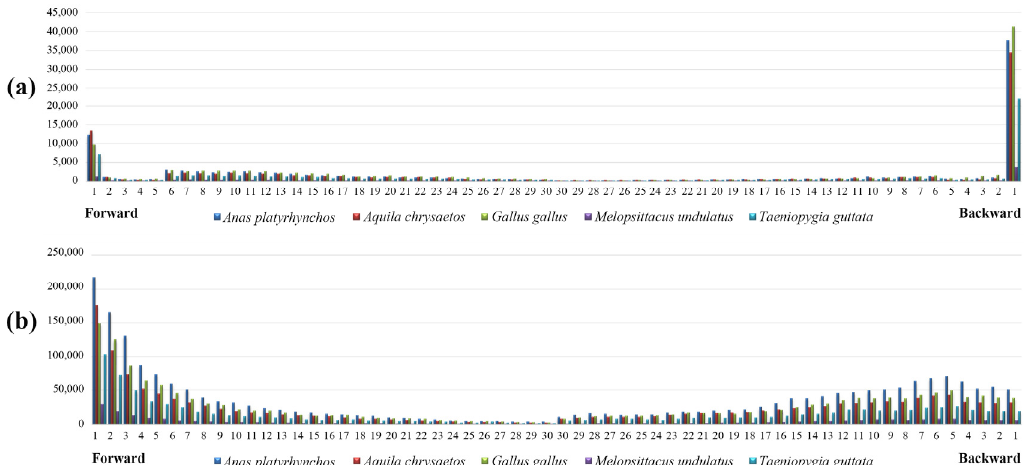
Figure 9. P-SSR distribution patterns in genes. ( a ) exons; ( b ) introns.